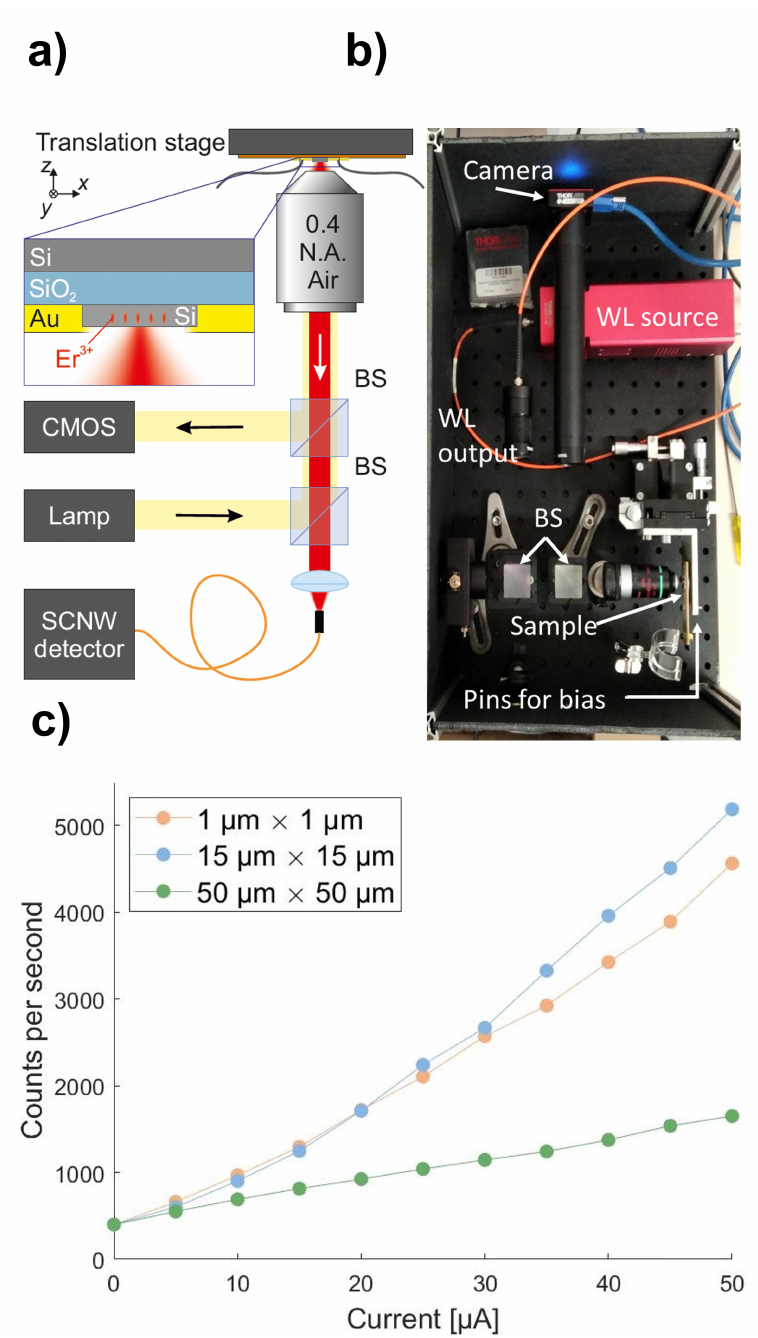
Figure 4. ( a ) Sketch of the experimental setup. ( b ) Picture of the the experimental setup (top view). ( c ) Counts collected per second in each device as a function of the current flux measured on the